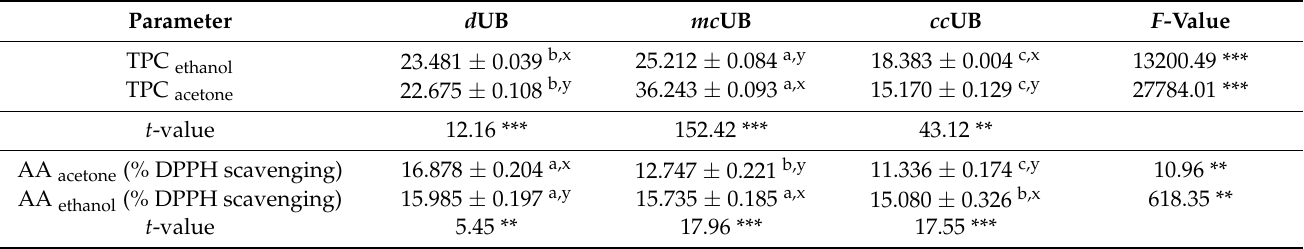
Table 3. Total phenolic content (TPC, expressed as mg PyE/g dried sample) and free radical scav- enging activity (AA, expressed as % DPPH radical scavenging) of U. barbata dried lichen and both fractions ( mc UB and cc UB) extracted in ethanol and